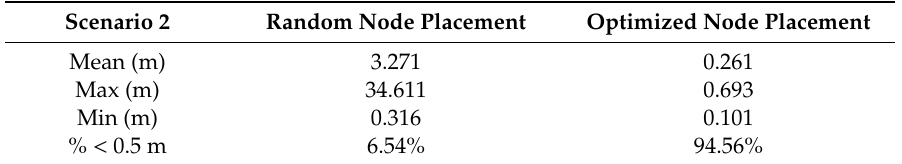
Table 6. Final results. CRLB statistics in Scenario 2 for random and optimized node distributions of 5 A-TDOA sensors.